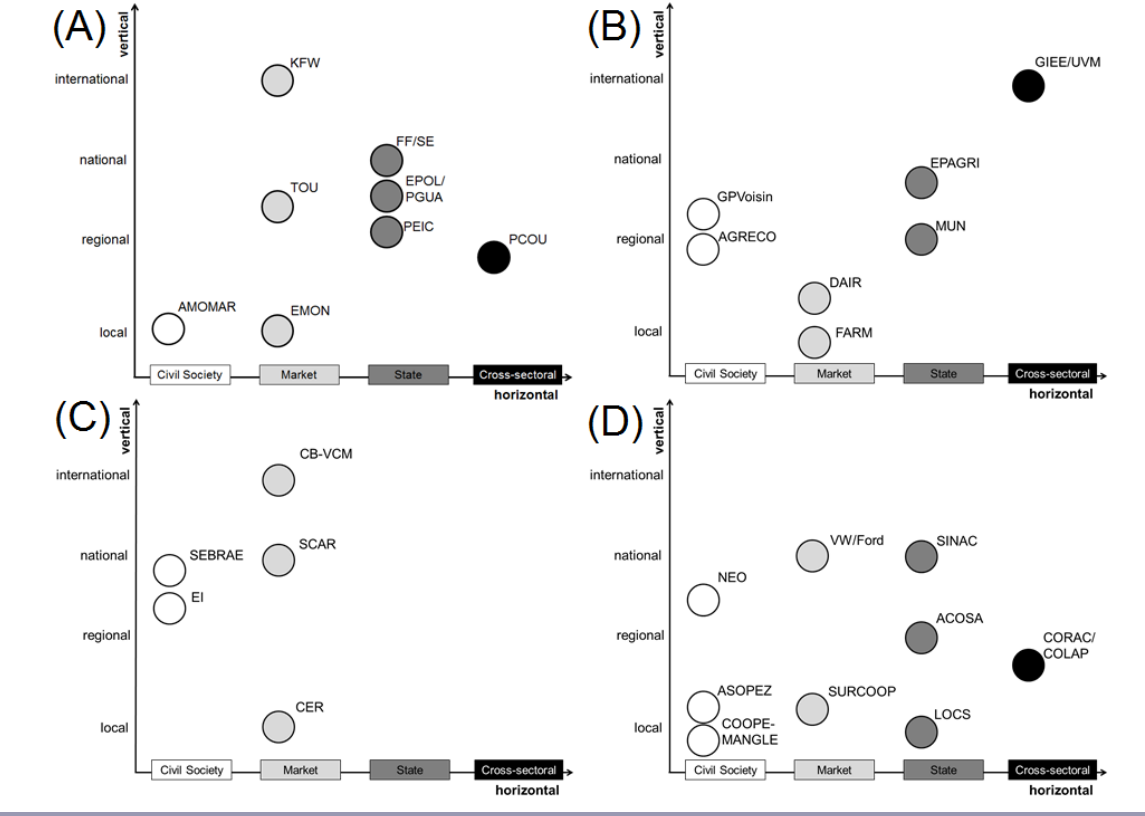
Fig. 2. Actors’ associations with societal sectors and level of governance engagement in each case study. (A) Marujá, (B) Santa Catarina, (C) Tocantins, (D) Osa. White = civil society (nonprofit) actors, light gray = market (corporate or private) actors, dark gray = state (government or public) actors, and black = cross-sectoral actors (e.g., research institutes or governance actors engaged in more than one